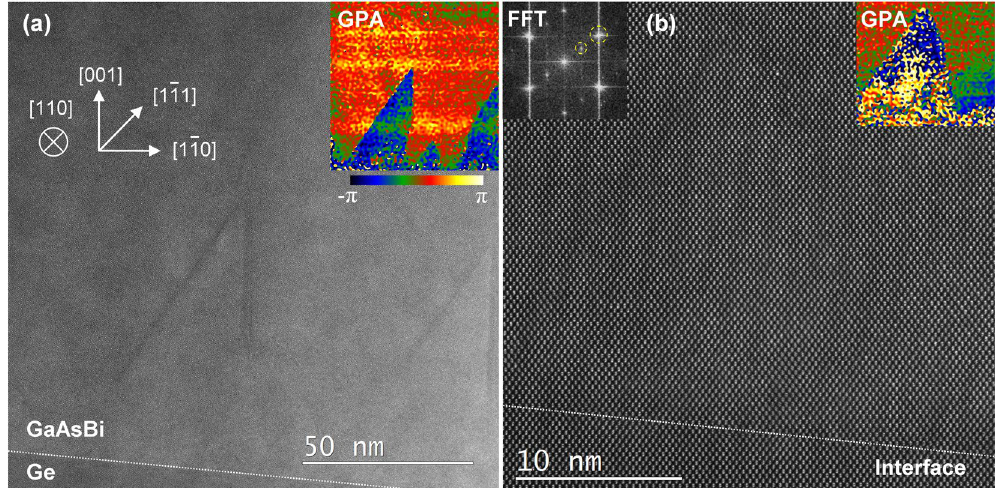
Figure 1. ( a ) A low-magnification HAADF image of the bismide sample S1 near the interface with Ge. A pair of asymmetric APDs are visible. Indicated crystallographic orientations are common for ( a , b ). The geometrical phase-map inset clearly outlines the APDs. ( b ) Atomic-resolution HAADF image near the interface showing an APD in the center, which is also outlined in the GPA inset. Small patches of single-variant CuPt ordering is seen in the lower right corner and confirmed in the Fourier transform (FFT) of the